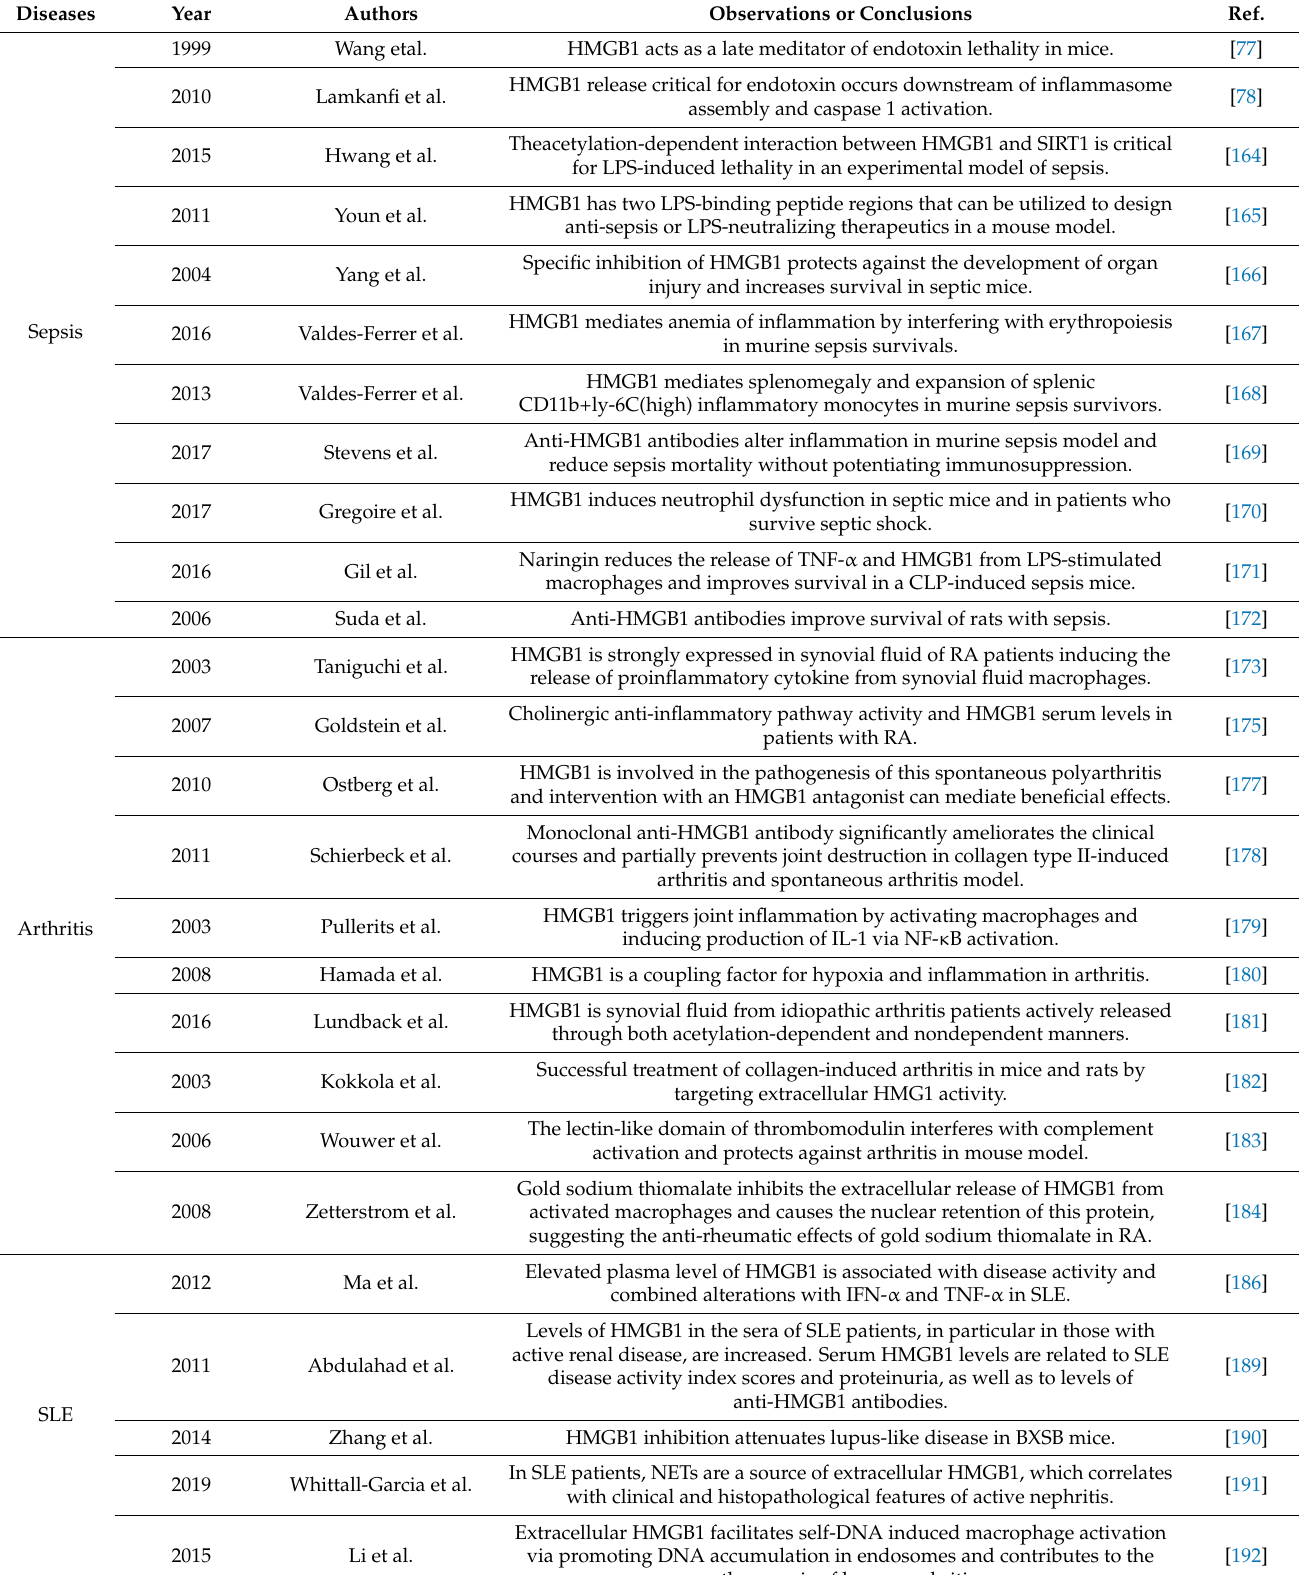
Table 1. Summary of studies concerning the significance of HMGB1 in various inflammatory diseases.